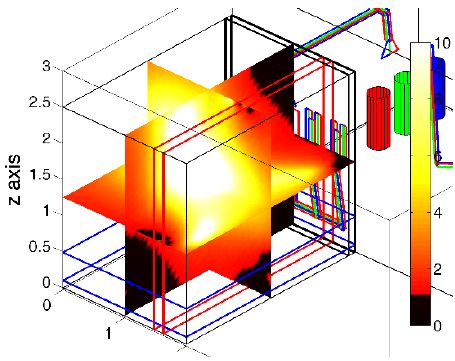
Figure 9. Optimal location for the active loops and RF (color bar) achieved in the center of the target volume outside a MV/LV substation.